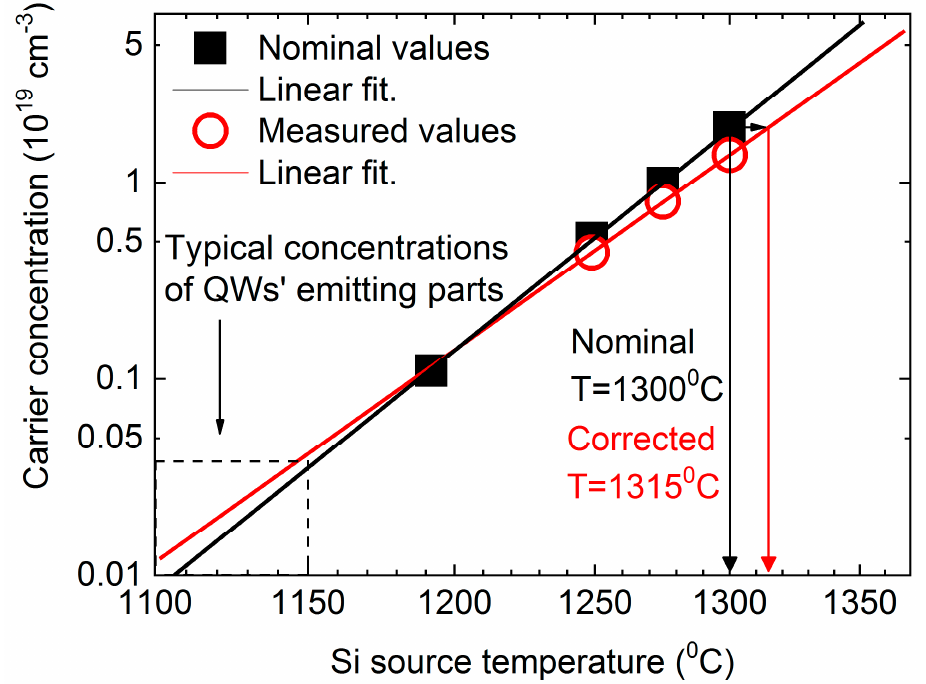
Figure 5. Nominal carrier concentrations (black squares) as a function of applied Si source temperature together with fit (black curve). Open red circles denotes corrected (in the way of second approach) values of the carrier concentration in a function of the applied Si source temperature together with respective fit (red curve).